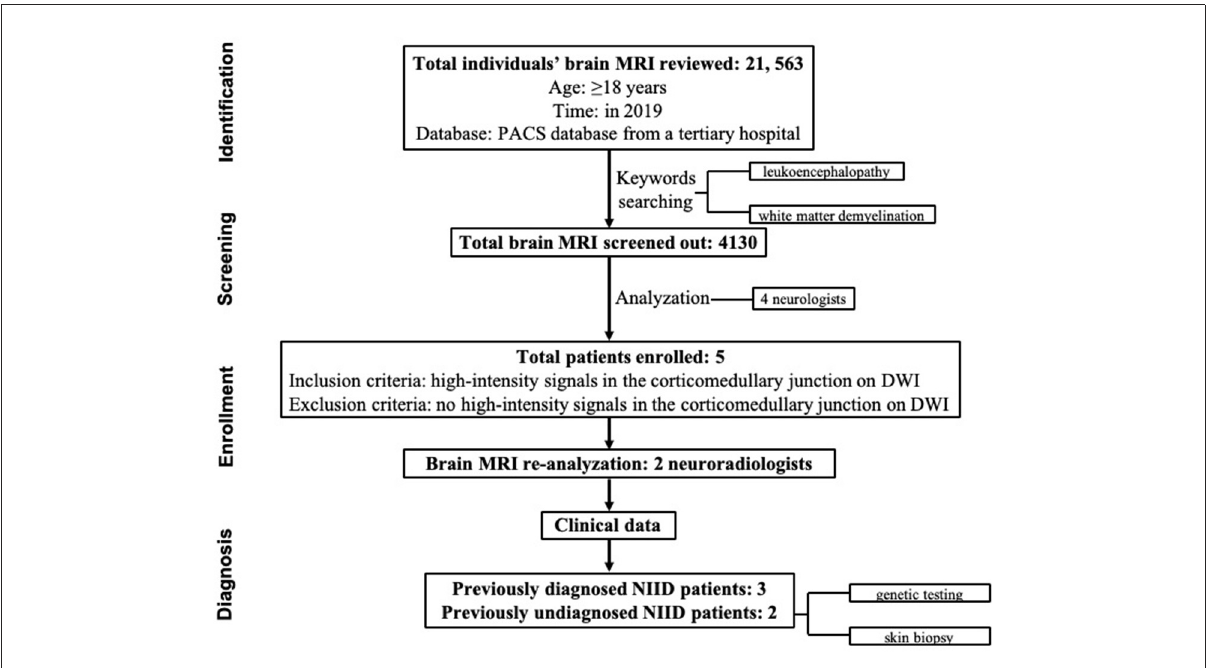
FIGURE1 Flowchart of the study enrollment